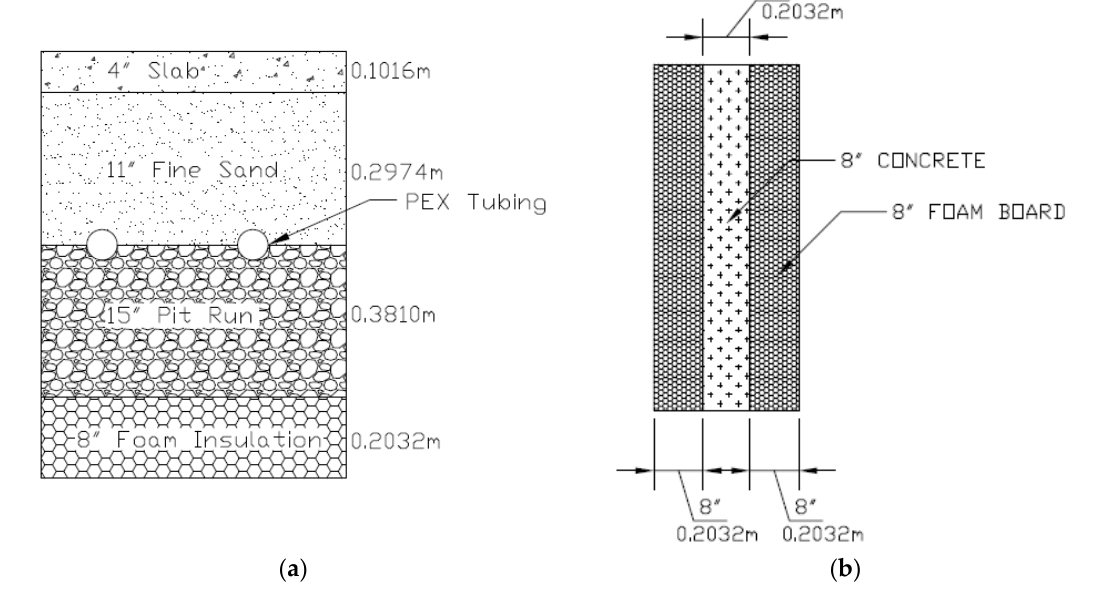
Figure 6. ( a ) Profile of solar thermal storage; ( b ) foundation wall cross ‐ section.